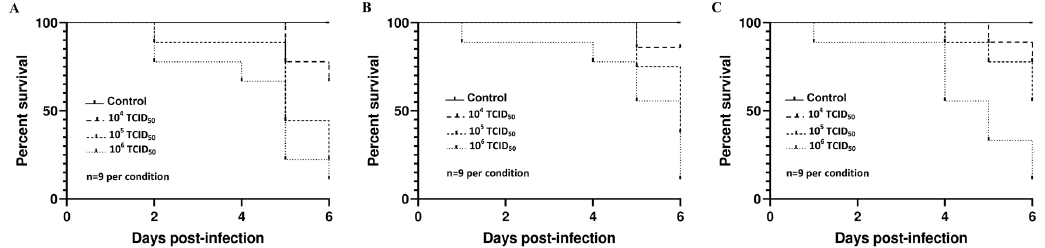
Figure 8. Kaplan–Meier survival curves for chicken embryos inoculated with three different doses of ( A ) Vienna 2001, ( B ) UR-10-Tm, and ( C ) USU-BE-Grivegnee/2017 Usutu virus strains using the allantoic route.